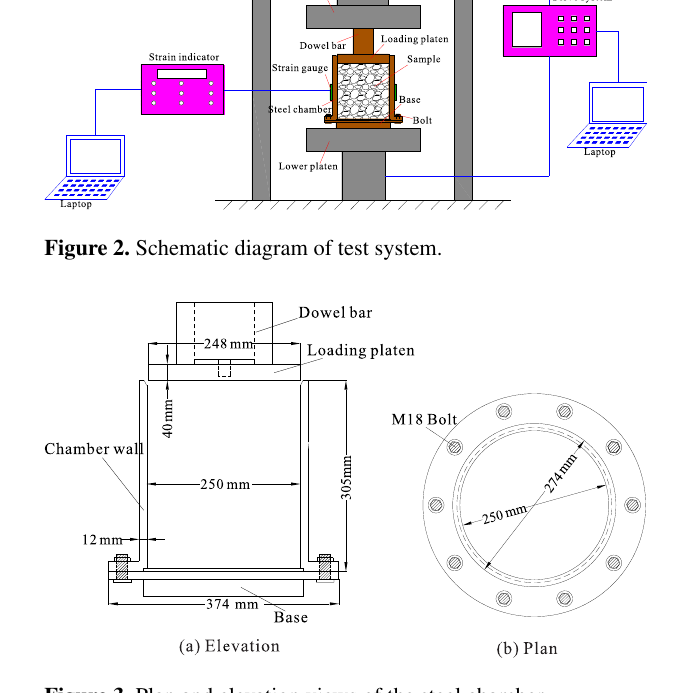
Figure 3. Plan and elevation views of the steel